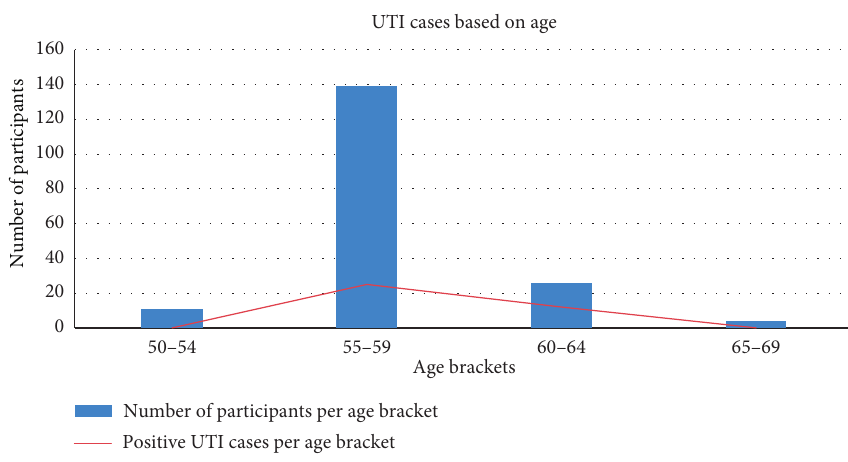
Figure 2: Total number of participants and positive UTI cases per age